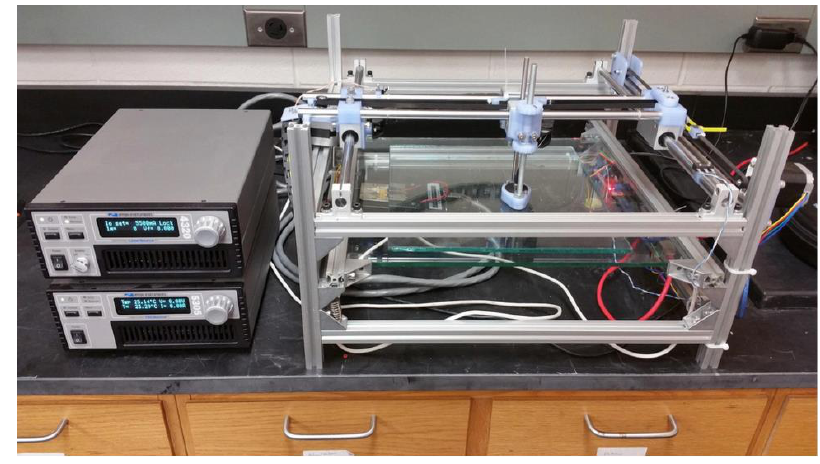
Figure 2. Completed open-source laser welder apparatus.